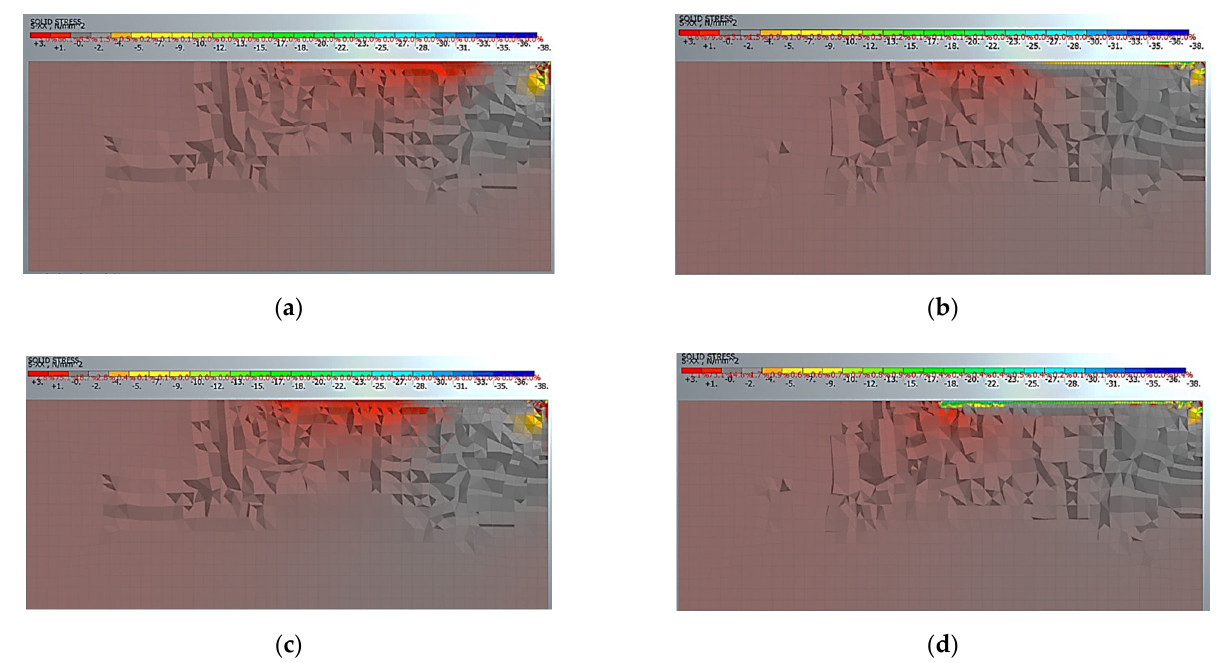
Figure 7. Longitudinal distribution of tensile stresses in the central section of the concrete block for the specimen